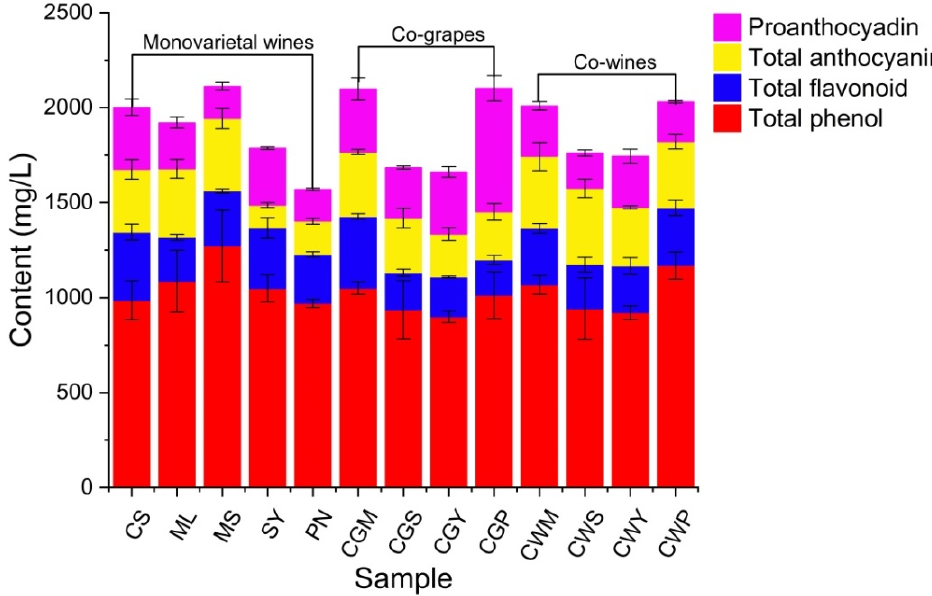
Figure 2. The composition of total phenol, total flavonoid, total anthocyanin and proanthocyadin of wine samples blended with different varieties and blending methods. wine samples blended with different varieties and blending